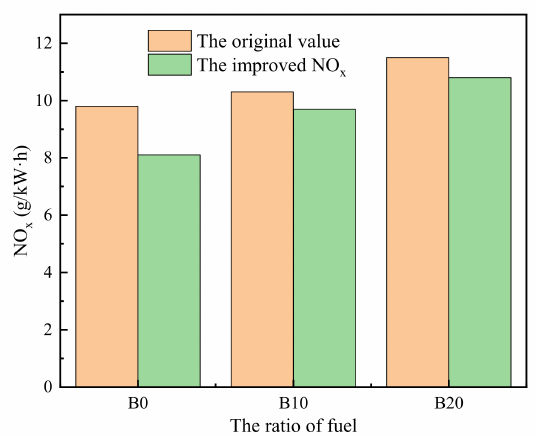
Figure 12. Comparison between the improved NO x and the original value under 75% load.